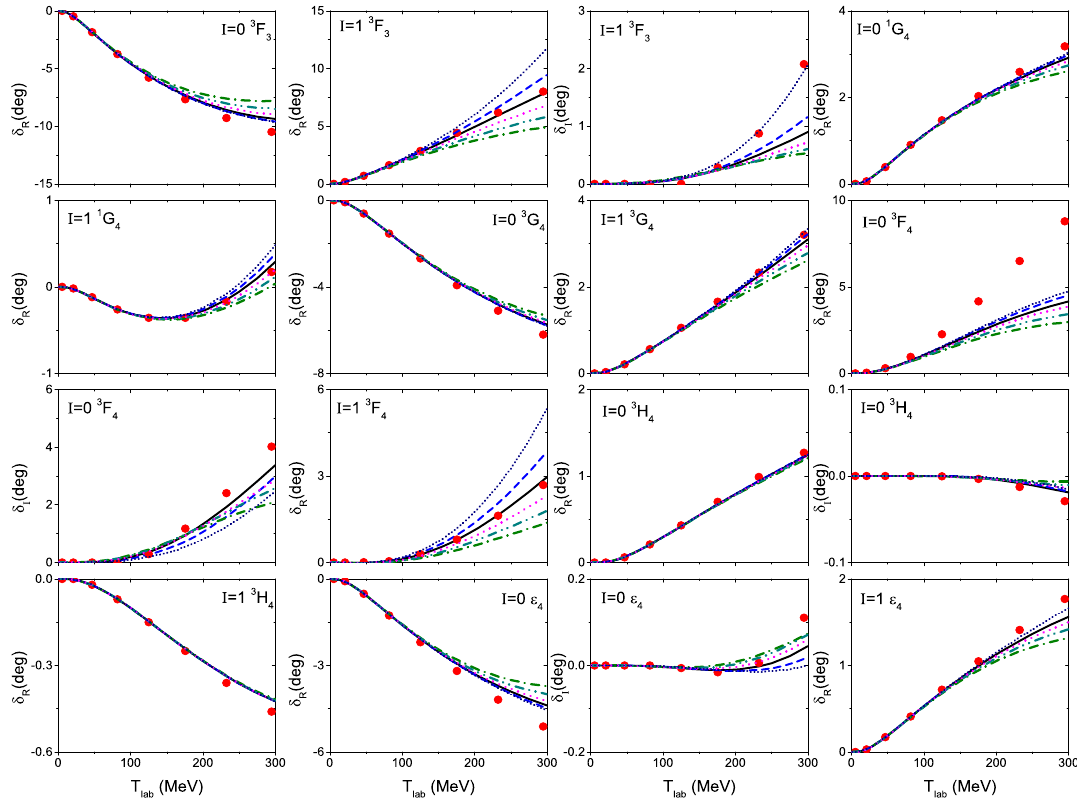
Figure 4 . Real and imaginary parts of various (cid:22) NN phase shifts at N 3 LO for cuto(cid:11)s R = 0 : 7{1 : 2 fm. The (cid:12)lled circles represent the solution of the (cid:22) pp PWA